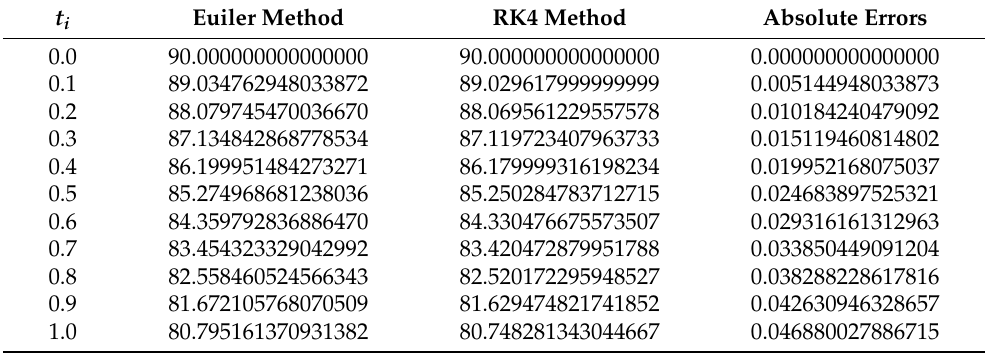
Table 2. Comparison between the results of the Euler method and RK4 method for S ( t ) .